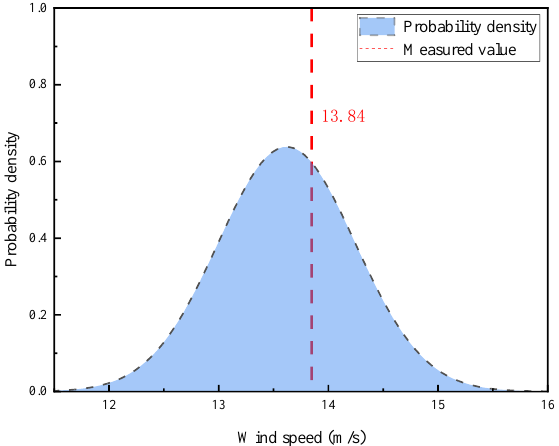
Figure 7. Probability density of predicted and actual values.